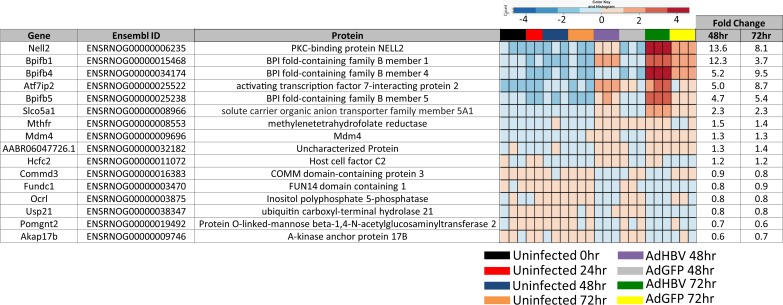
Description of HBV-only subset of differentially expressed genes.Gene name, Ensembl ID, and associated protein name are given for genes within the HBV-only subset of genes. Fold changes comparing expression in AdGFP to AdGFP-HBV at the indicated time points is included, along with a heatmap depicting expression variation (by Z-score) across all samples.